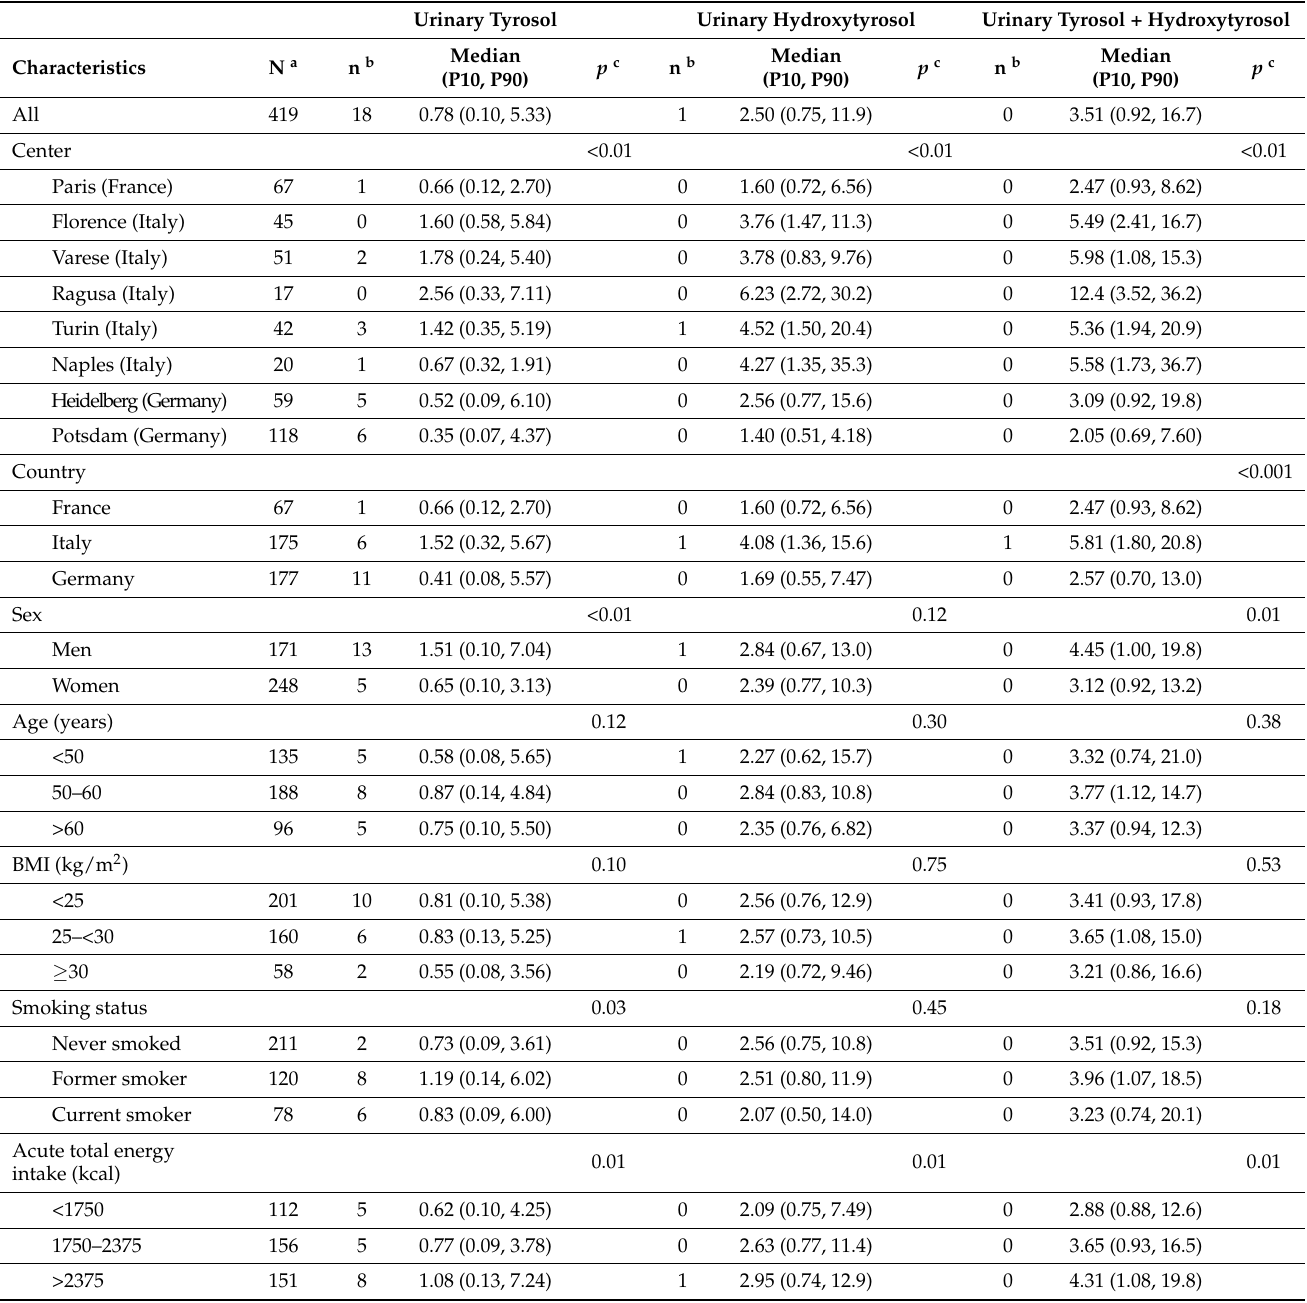
Table 1. Distribution of 24 h urinary excretions ( µ mol/24 h) of tyrosol and hydroxytyrosol and their sum, according to sociodemographic and lifestyle characteristics of participants (n = 419) of the EPIC